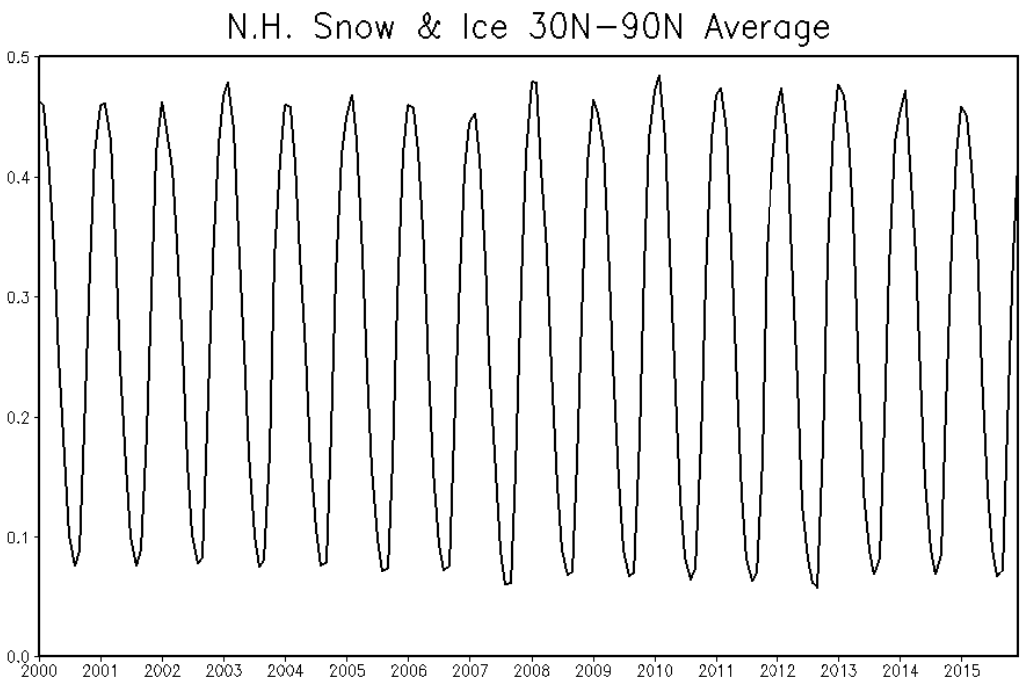
Figure 12. Time series of the mean 30°N – 90°N average monthly combined snow and ice fraction from the indicated satellites (upper) and the IMS analysis (lower).